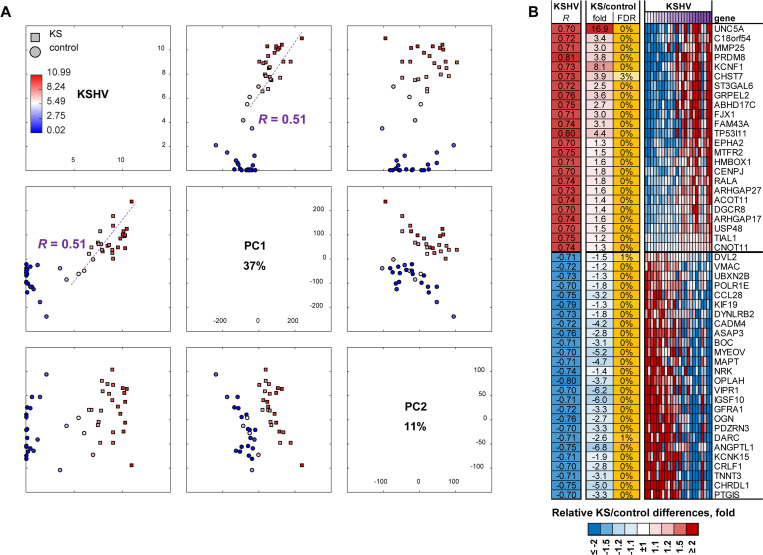
Correlation between KSHV RNA load/reads and cellular gene expression.(A) Principal component analysis (PCA) showing relationship between first and second principal components (PC1, PC2) and KSHV RNA load/RNA in KS lesion vs control. (B) Heatmap for top 50 genes correlated with KSHV RNA load/read that were also up- or down-regulated in KS lesions vs controls. KSHV–Kaposi’s sarcoma (KS)-associated herpesvirus.